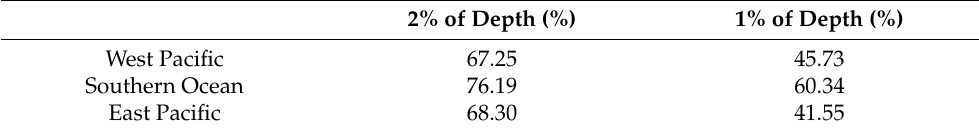
Table 4. Proportion of corrected errors from truth values within 2% and 1% depth